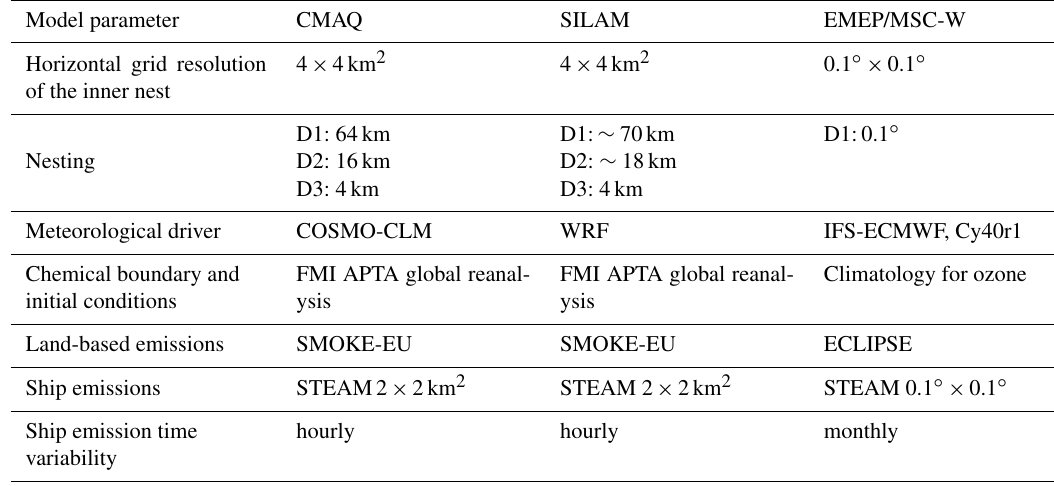
Table 1. Description of the model set-up of the three CTM systems. Model parameter CMAQ SILAM EMEP/MSC-W Horizontal grid resolution